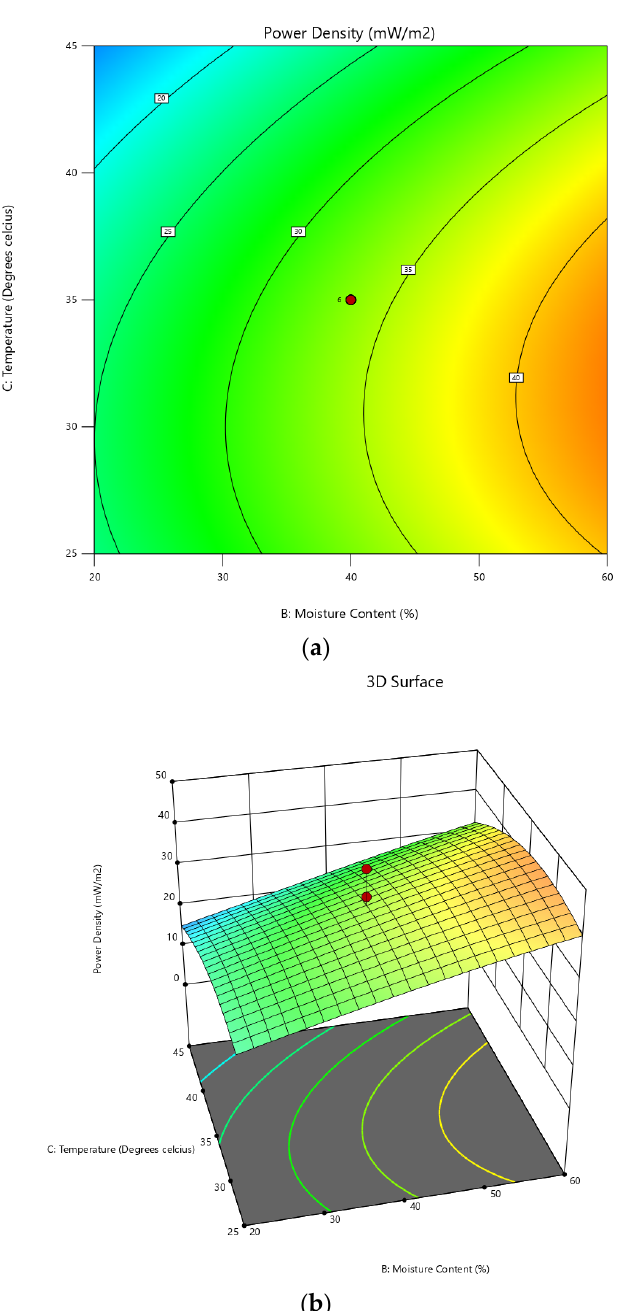
Figure 9. ( a ) Contour plot and ( b ) response surface plot of power density generation as a function of moisture content relative to electrode distance.